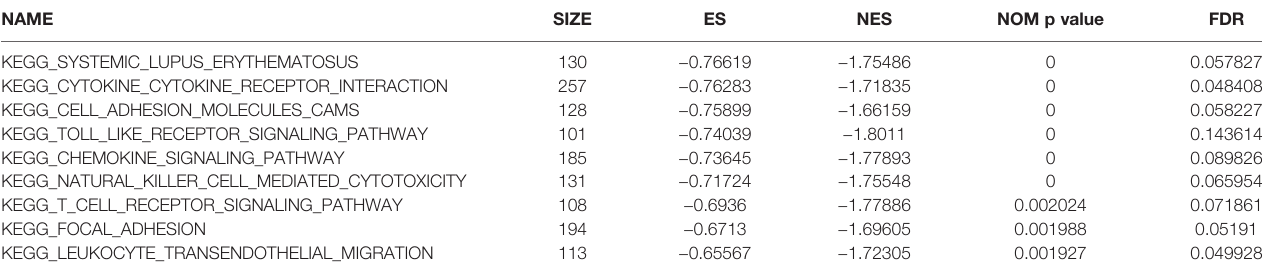
TABLE 2 | Genet set enrichment analysis (GSEA) in CD86 high-expression phenotype.